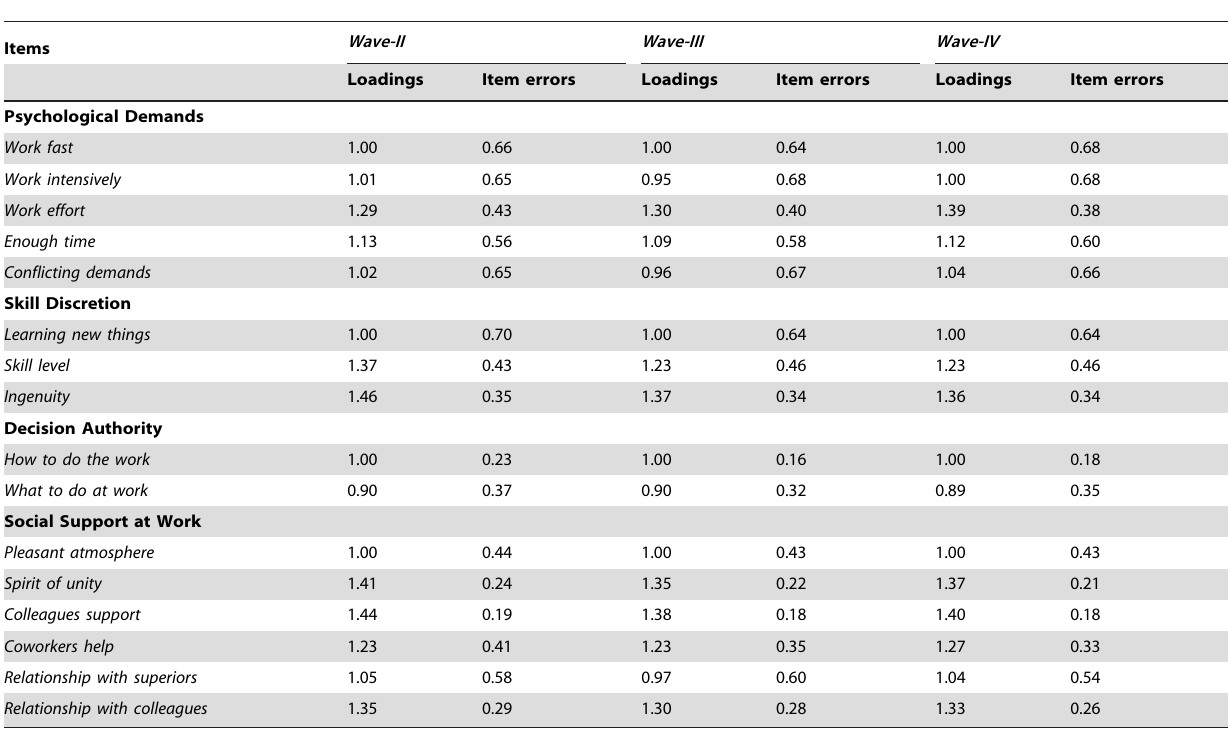
Table 8. Unconstrained unstandardized factor loadings, and error variances in the configural invariance model of the DCSQ over